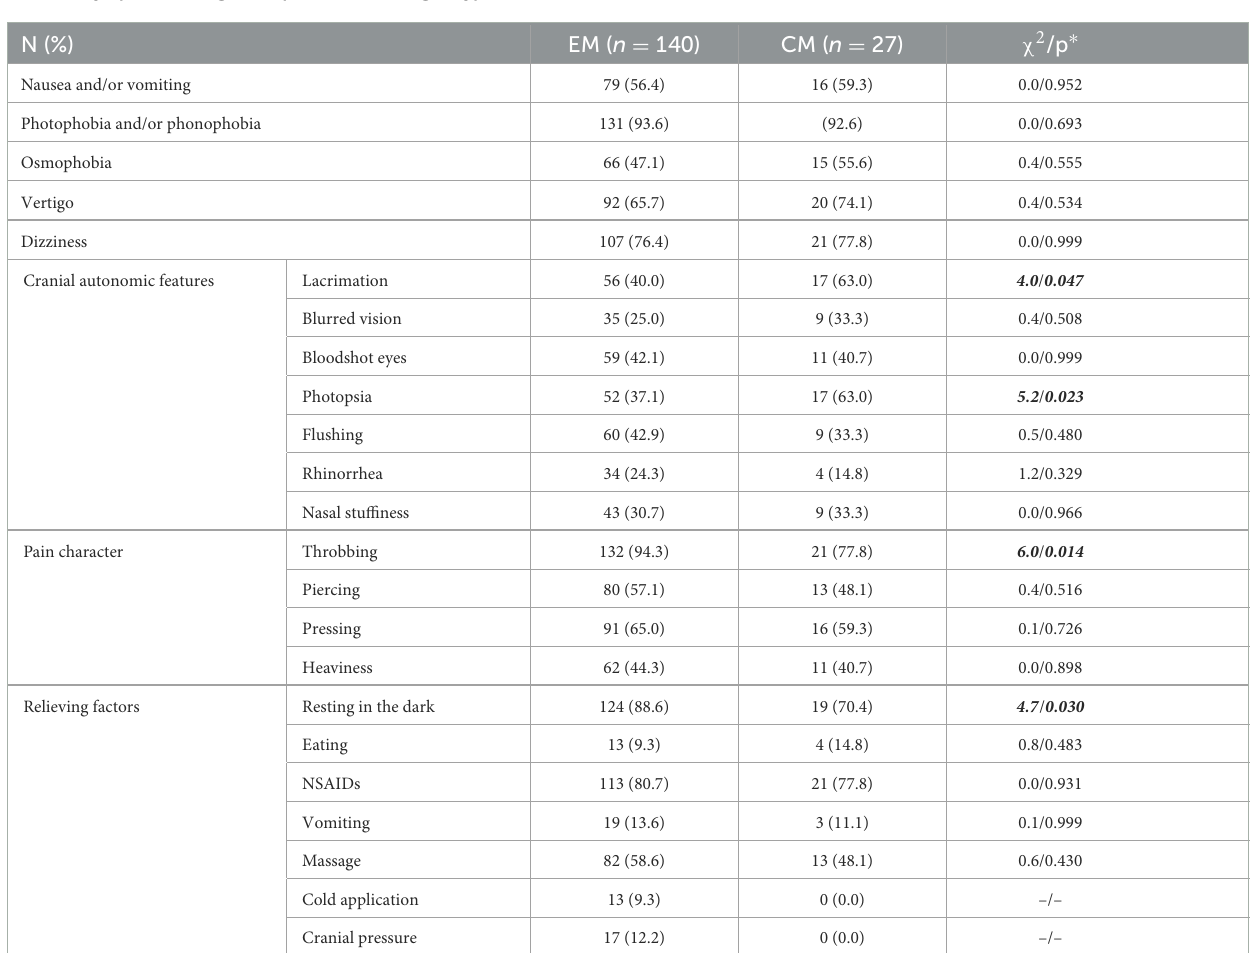
TABLE 4 Symptoms of migraine episodes according to